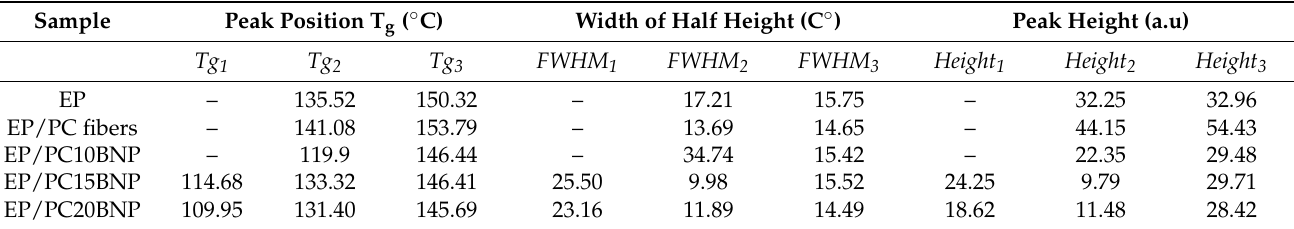
Table 3. Tan δ Second